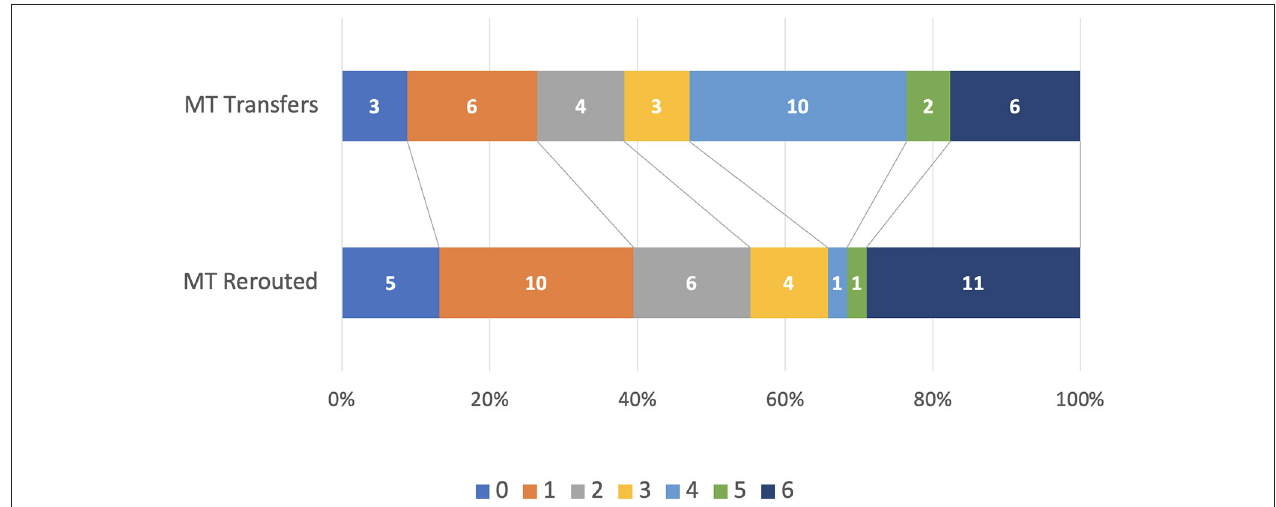
FIGURE 3 | Modified Rankin Score distribution in rerouted vs. transferred MT